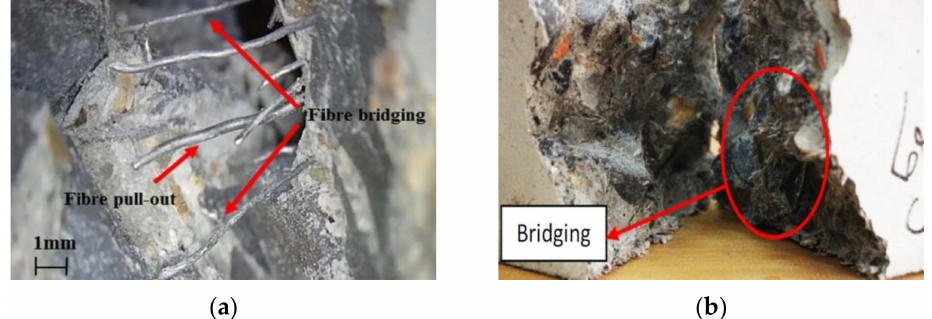
Figure 7. Flexural failure of fiber-reinforced concrete: ( a ) [70]; ( b ) [88].